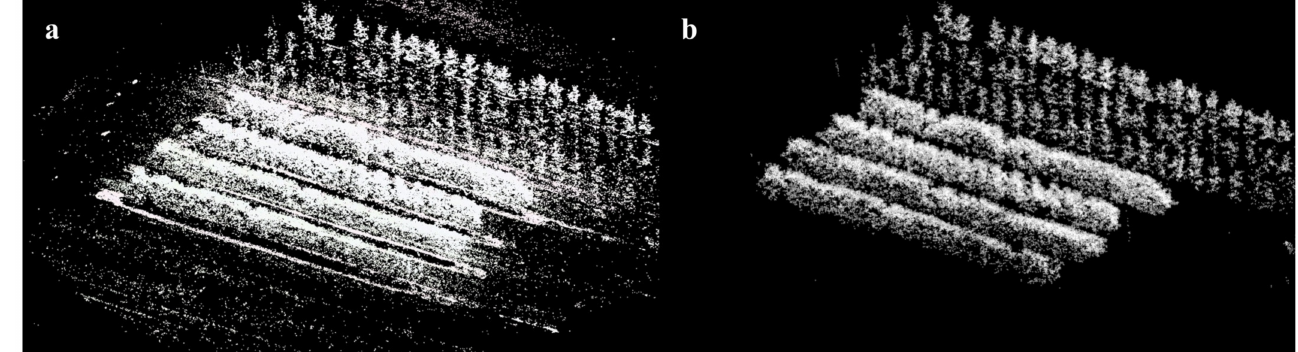
Figure A6. Blossom point cloud extraction from the sample orchard point cloud: ( a ) raw blossom point cloud extracted using white color thresholding; ( b ) height-adjusted, noise-removed, downsam- pled blossom point